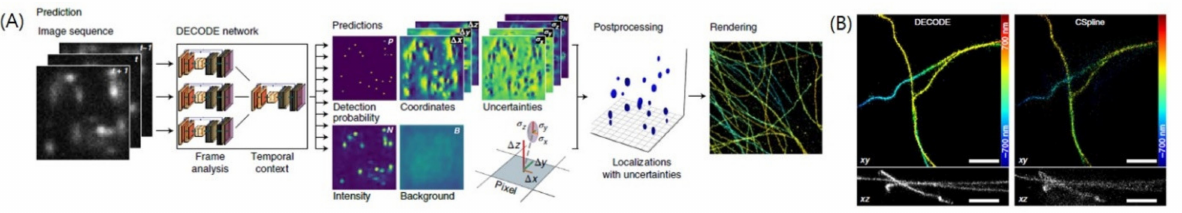
Figure 7. A deep-learning-based method for localization of overlapping PSFs. ( A ) The network archi- tecture of DECODE. Using the information from multiple image frames, DECODE predicts output maps representing the detection probability, subpixel spatial coordinates, brightness, uncertainty, and an optional background for each pixel. ( B ) Comparison between the performances of the DECODE and the CSpline algorithm for the high density, low signal double-helix challenge training data. Scale bars, 1 µ m. Adapted with permission